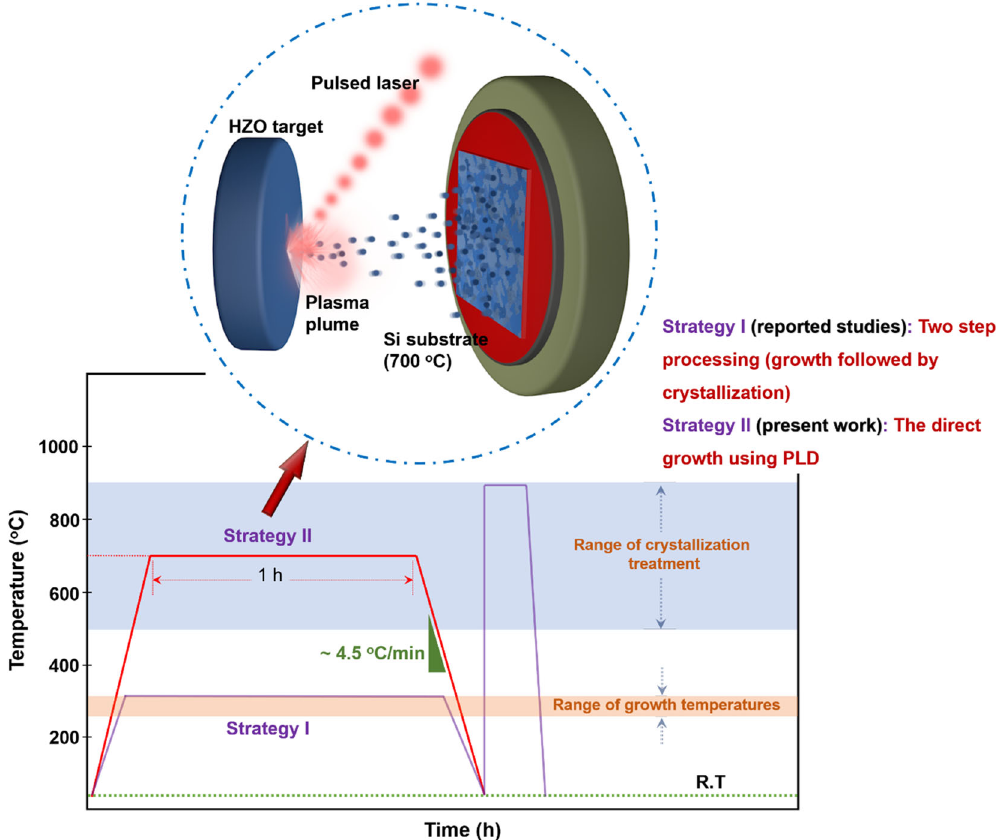
Fig. 1 Deposition and post-processing strategies using PLD and conventionally used ALD and CSD techniques. The schematic representing the growth of HZO thin fi lm on preheated Si substrate (Note: R.T: Room